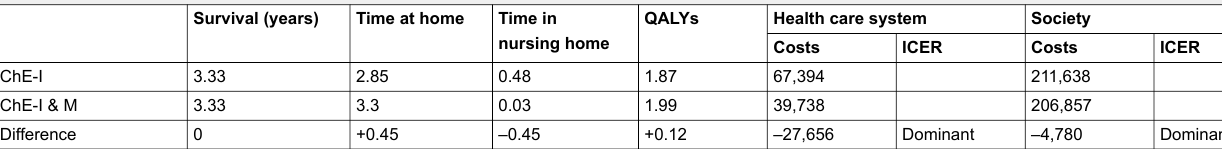
Table 5: Incremental costs and cost-utility result over 5 years